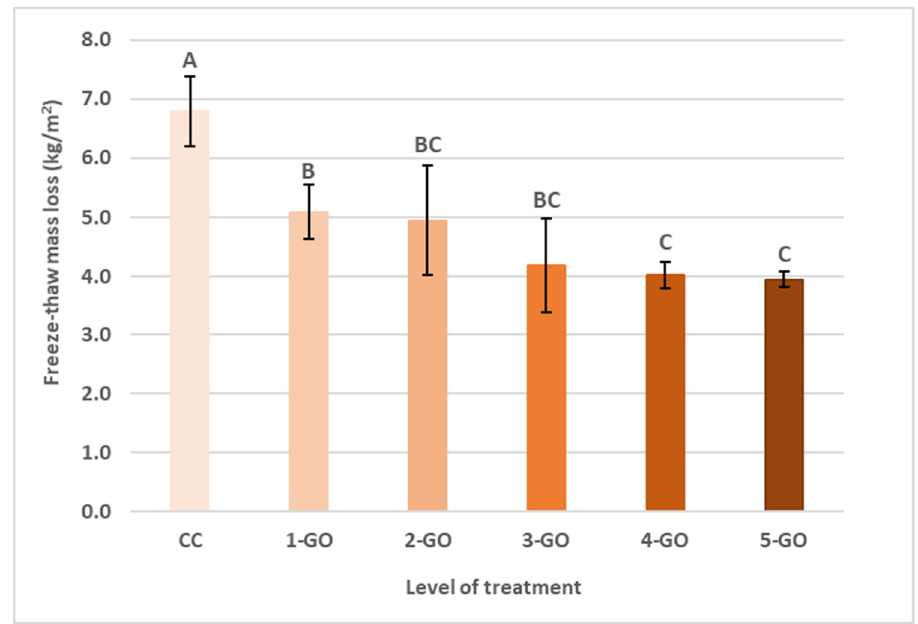
Figure 4. Mass loss after freeze-thawing cycles at different treatment levels. Capital letters indicate minimum significant differences between treatment levels. Vertical bars represent mean and standard error (SE). Statistical differences are indicated by different letters (LSD test, p < 0.05).